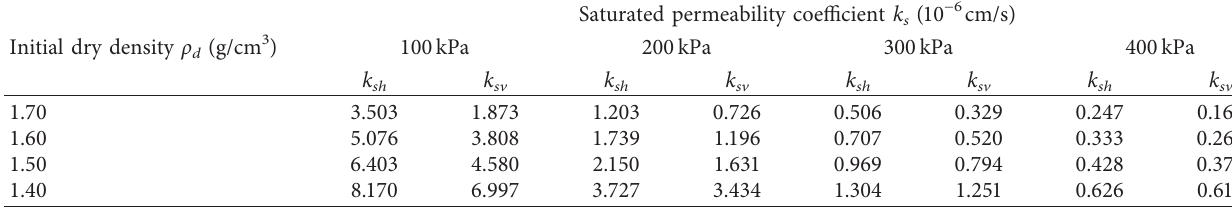
Table 2: Permeability coefficient of saturated compacted loess under confining